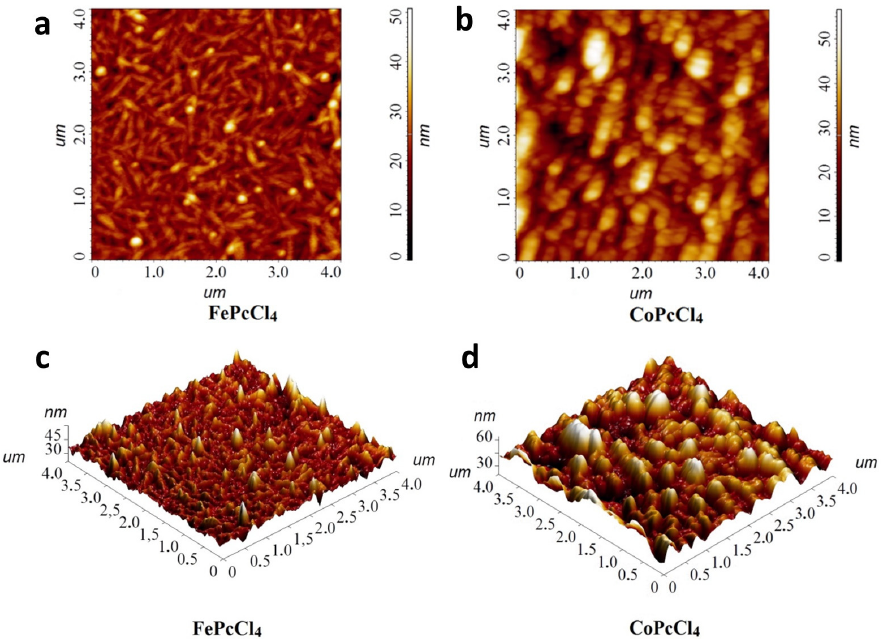
Figure 10. 2D and 3D AFM images of FePcCl 4 ( a , c ) and CoPcCl 4 films ( b , d ).